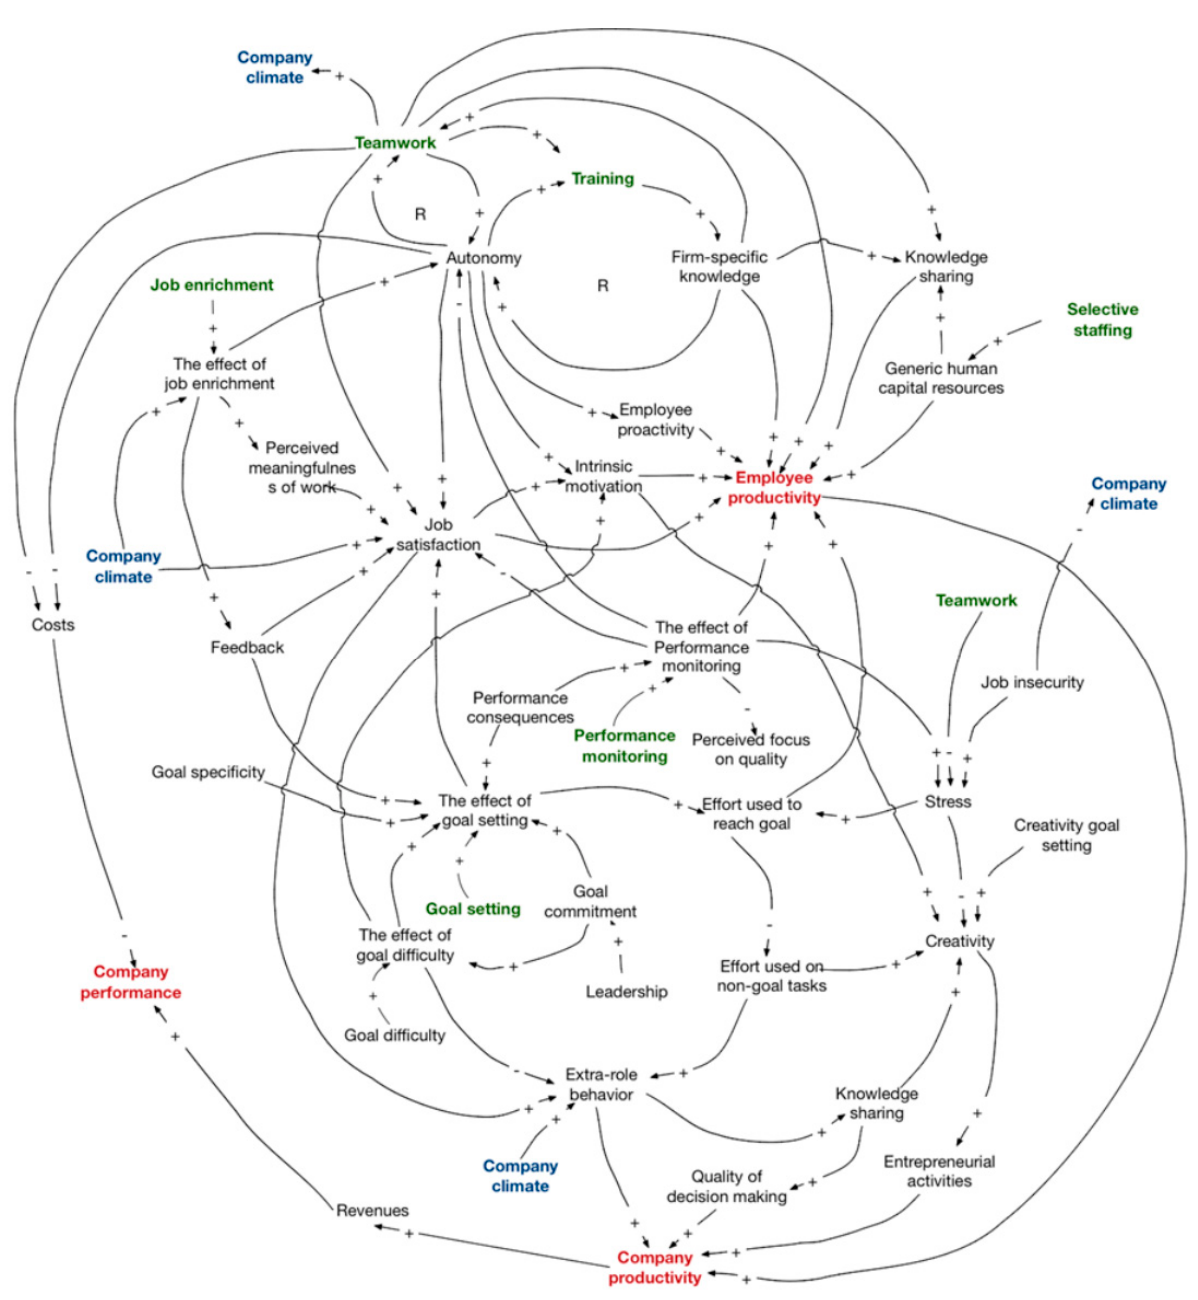
Figure 9. The final result: the synthesis step 2 CLD describing the causalities of employee productivity in an organizational setting.